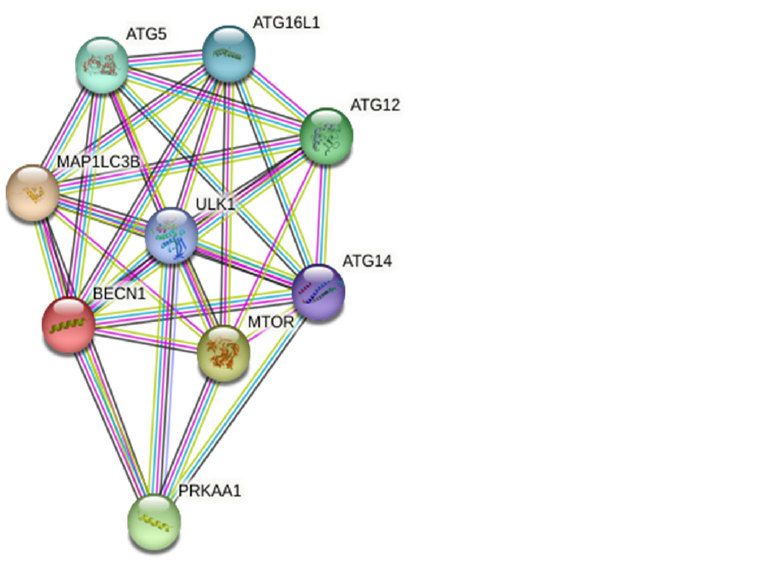
Table 1. List of microRNAs associated with thyroid cancer. Change in